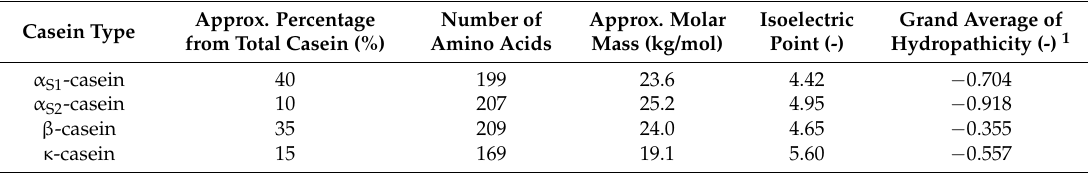
Table 1. Characteristics of main casein types in bovine milk [17].